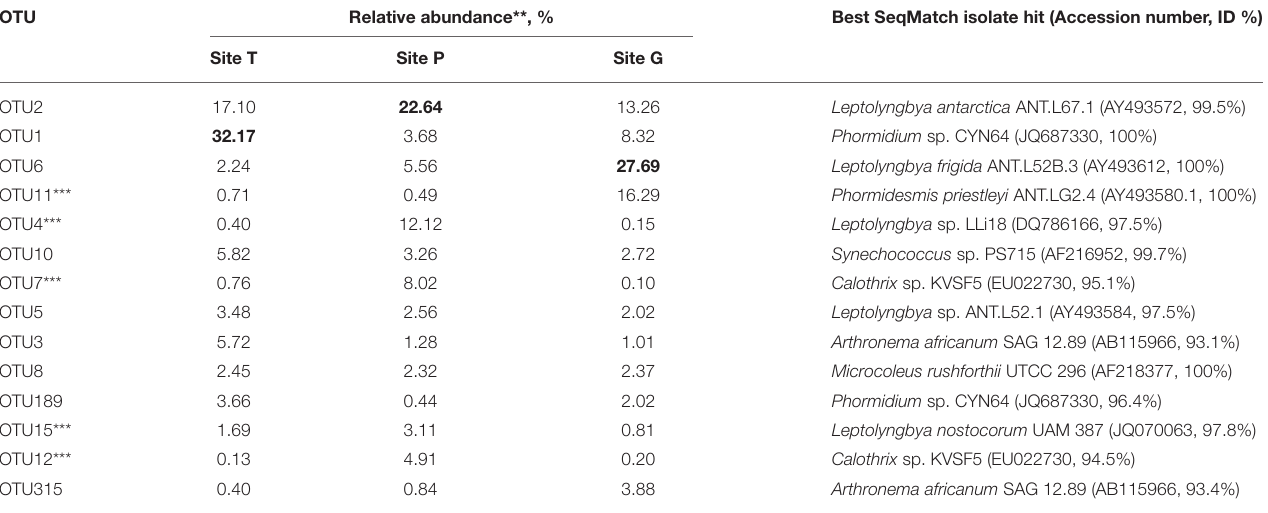
TABLE 3 | The most abundant * cyanobacterial operational taxonomic units (OTUs) in the three sites.